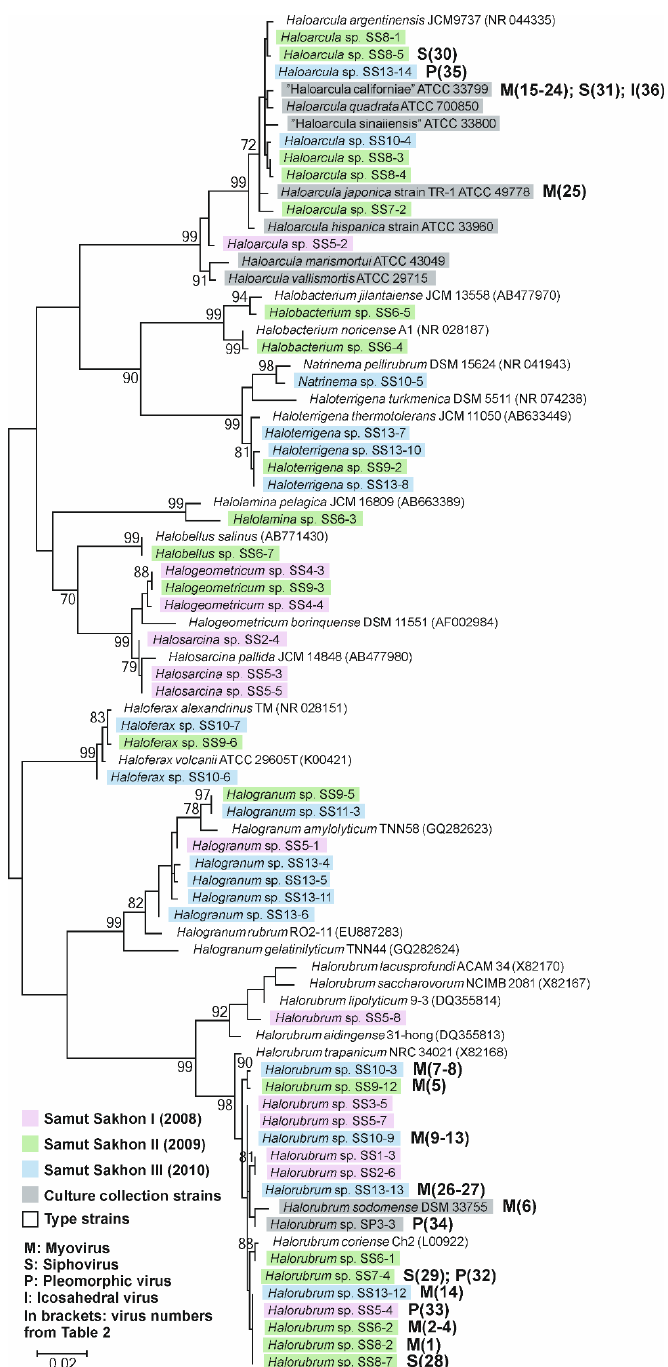
Figure 1. Maximum likelihood phylogenetic tree of haloarchaeal partial 16S rRNA gene sequences. The archaeal strains obtained from SSI samples [22] are marked with pink. SSII and SSIII strains are highlighted with green and blue, respectively. The culture collection strains used in this study are highlighted with grey. The accession numbers of SSII and SSIII strains are listed in Table 1. Accession numbers of SSI strains can be found from [22]. Reference strains have accession numbers but no color codes. Virus isolates are marked with their virus numbers (See Table 2) in brackets and a letter indicating the virus morphotype (See the bottom left corner of the figure) after the strain name. Bar (0.02) represents inferred substitutions per nucleotide